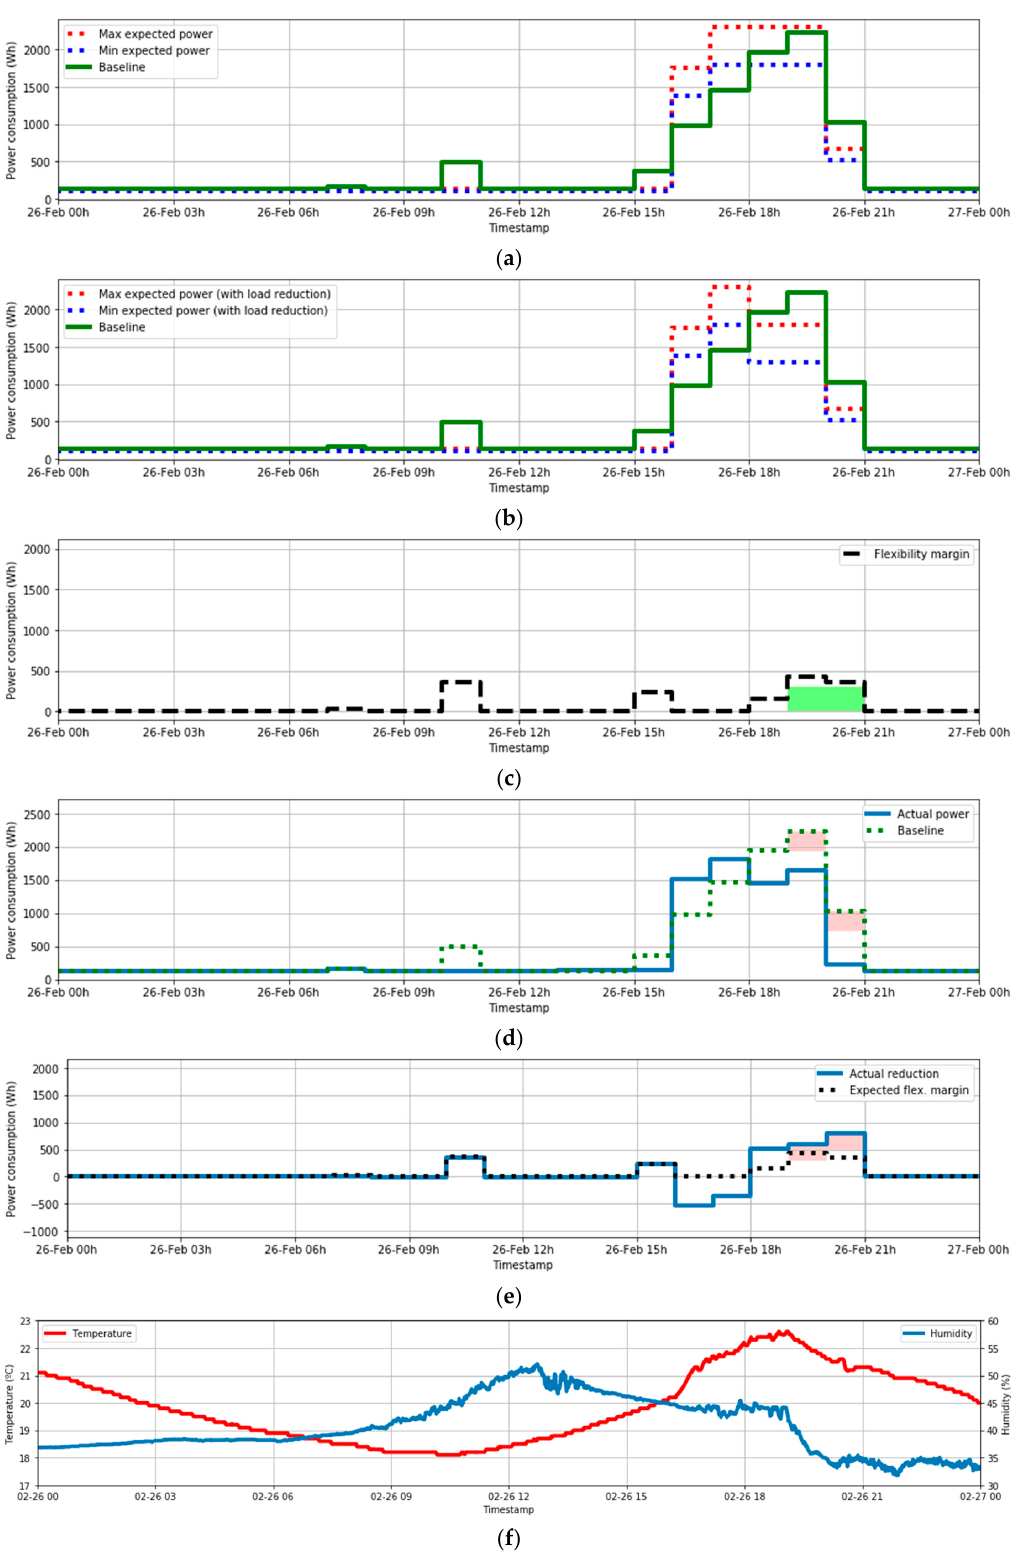
Figure 11. ( a ) Occupancy-based (from BMS) and Historical-based (baseline) expected power; ( b ) Occupancy-based (from BMS) and Historical-based (baseline) expected power—Load reduction considered; ( c ) Expected flexibility Margin (only values > 0). Reduction really requested by the DSO (in green); ( d ) Actual power and baseline. Requested power reduction (in red); ( e ) Reduction achieved vs. Expected Flexibility Margin. Requested power reduction (in red); ( f ) Temperature (red) and humidity